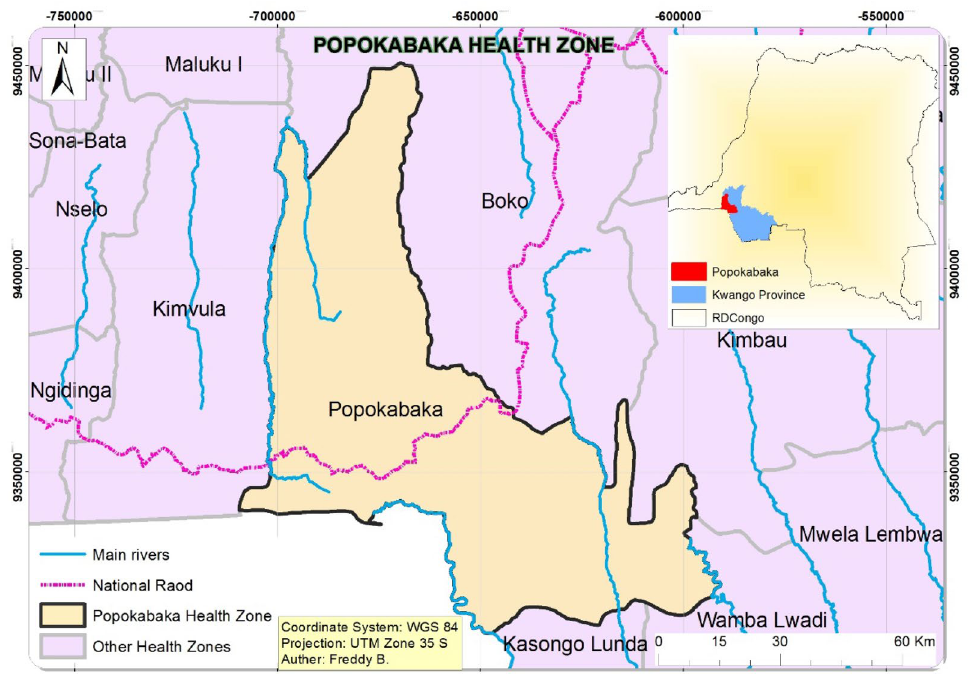
Figure 3. Location of Popokabaka Health Zone. Source: shapefile downloaded from the Humaniterian Data Exchange (https:// data. humda ta. org/ datas et/ drc- health- data) and map created by Freddy Bangelesa using ArcGIS 10.4,